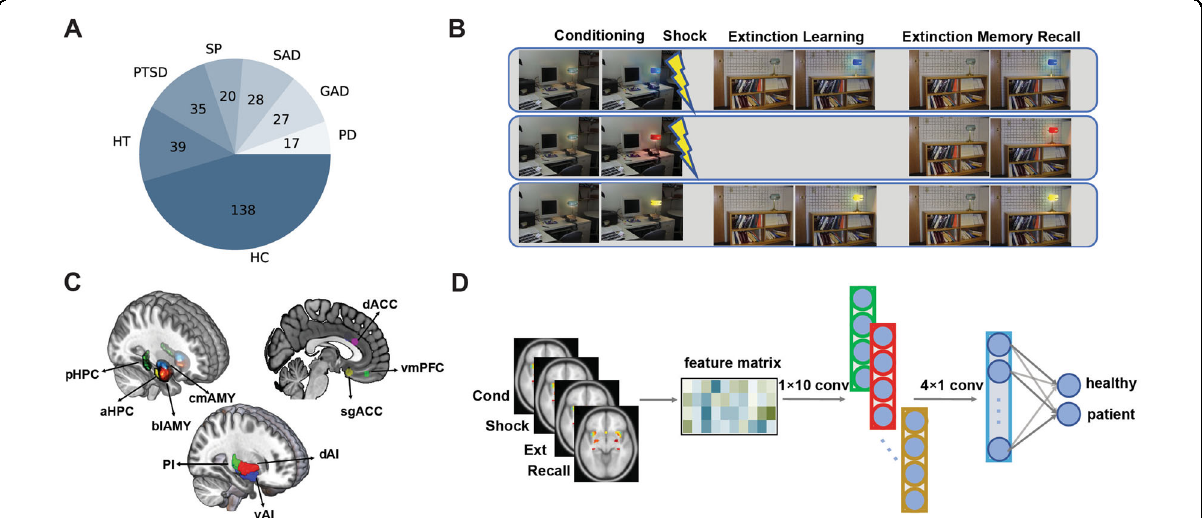
Fig. 1 Overview of data, experimental paradigm, and neural network classi fi er. A Summary of participants in each category. HC healthy control, HT trauma-exposed healthy, PTSD post-traumatic stress disorder, SP speci fi c phobia, SAD social anxiety disorder, GAD generalized anxiety disorder, PD panic disorder. B The fear conditioning and extinction paradigm consisting of four phases: fear conditioning ( ‘ Cond ’ ), unconditioned shock ( ‘ Shock ’ ), extinction learning ( ‘ Ext ’ ), and extinction memory recall ( ‘ Recall ’ ). C Ten target brain regions within the fear network. D Architecture of a three-layer convolutional neural